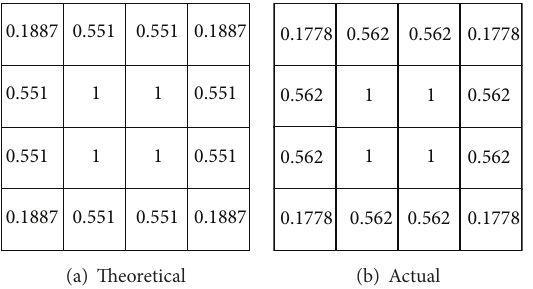
Figure 11: Theoretical and actual amplitude tapering values (linear scale values are displayed here in order to compare the configurations).